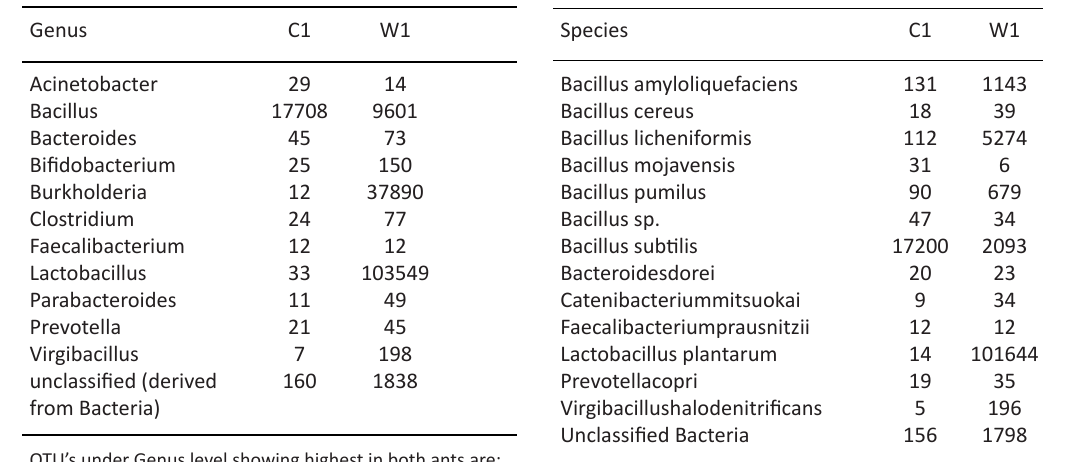
Table 9. Taxa Statistics at Species level Table 8. Taxa Statistics at Genus